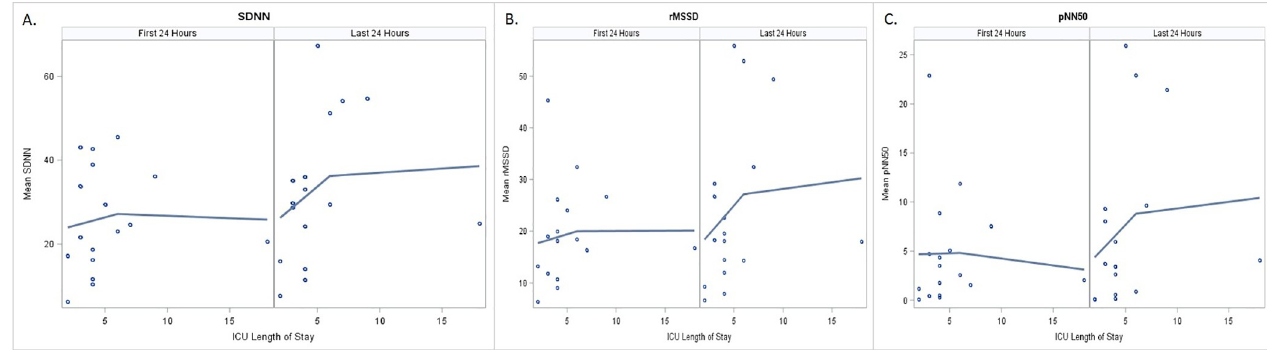
Fig 4. Mean heart rate variability and PICU Length of stay. Mean HRV for a) SDNN; b) RMSSD, and c) pNN50 plotted against PICU length of stay the first 24 hours of PICU stay in the left panel and the last 24 hours in the right panel of each graph.